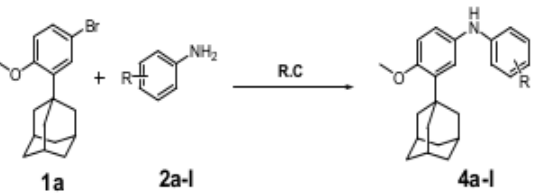
amines to obtain adamantanyl-tethered-biphenyl amines (ATBAs). R.C: Reaction conditions; PS-Co